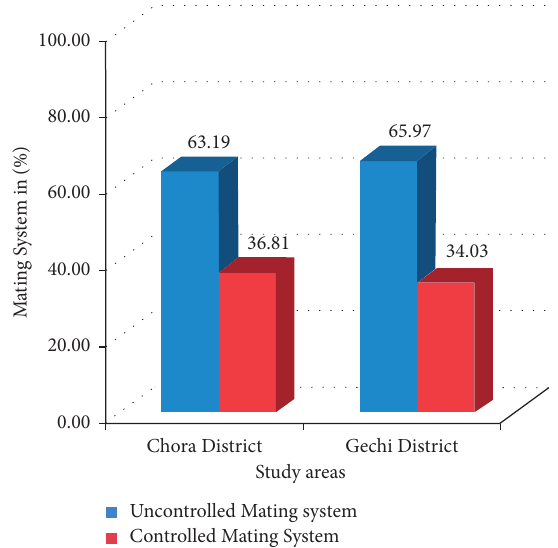
Figure 1: Proportion of controlled and uncontrolled cattle mating systems in the study